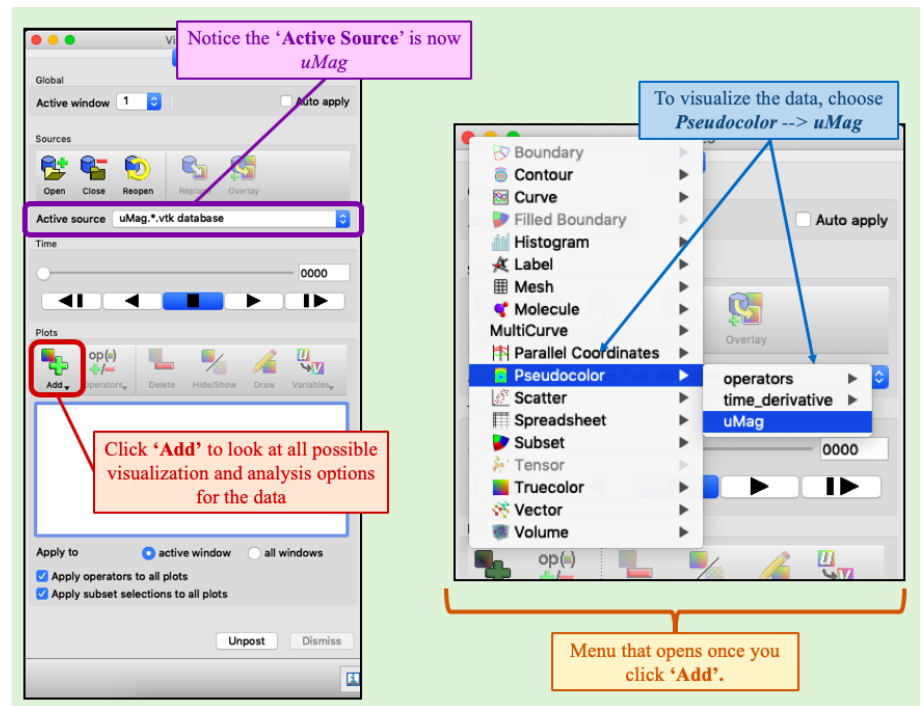
Figure 10. Opening specific simulation data to visualize in